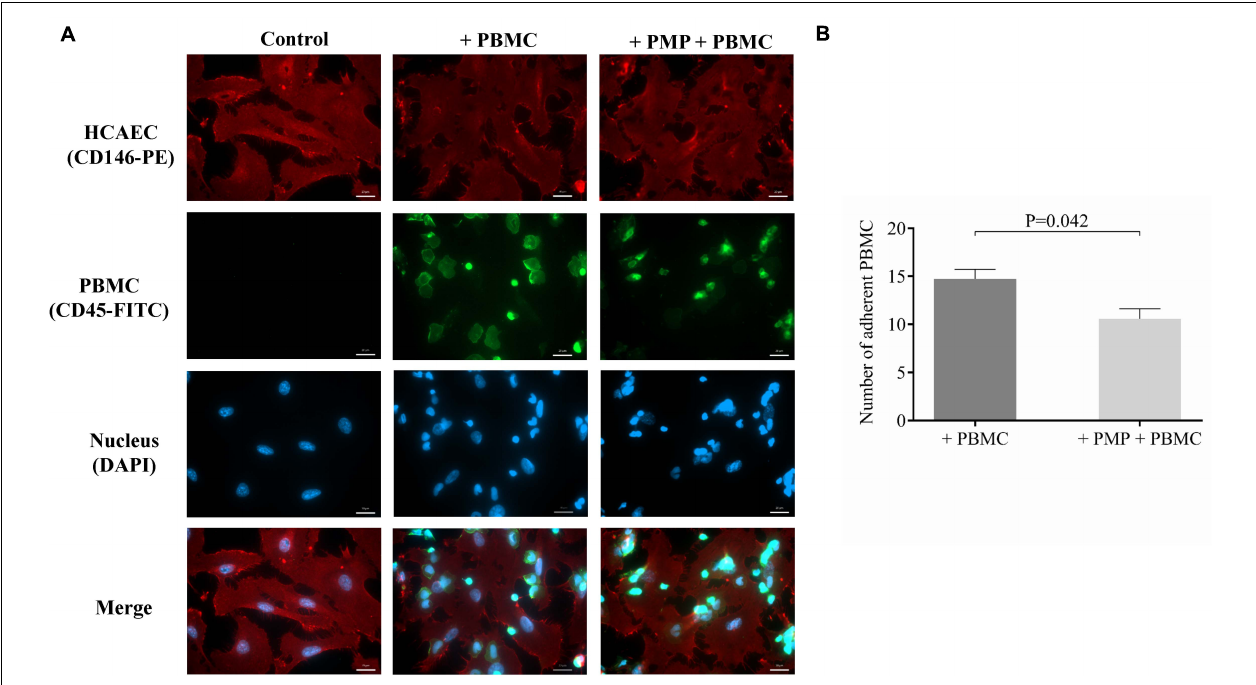
FIGURE 6 | Investigation of reduced adhesion of PBMCs to endothelial cells after septic PMP treatment. HCAECs were seeded and pretreated with septic platelet-derived microparticles (PMPs) for 24 h. Cells were subsequently incubated with TNF- α -activated peripheral blood mononuclear cells (PBMCs) for 1 h. Endothelial cells were stained with anti-CD146-PE antibody (red) and PBMCs with anti-CD45-FITC antibody (green). The binding of PBMCs to the surface of endothelial cells was investigated by fluorescence microscopy (A) . Blue: cell nuclei. Less adherent PBMCs could be detected in PMP-pretreated HCAECs vs. non-treated cells (B) . Scale bar: 20 µ m. Results are expressed as mean ± SEM. Mann-Whitney U -test was performed for comparisons. ( n = 5–6